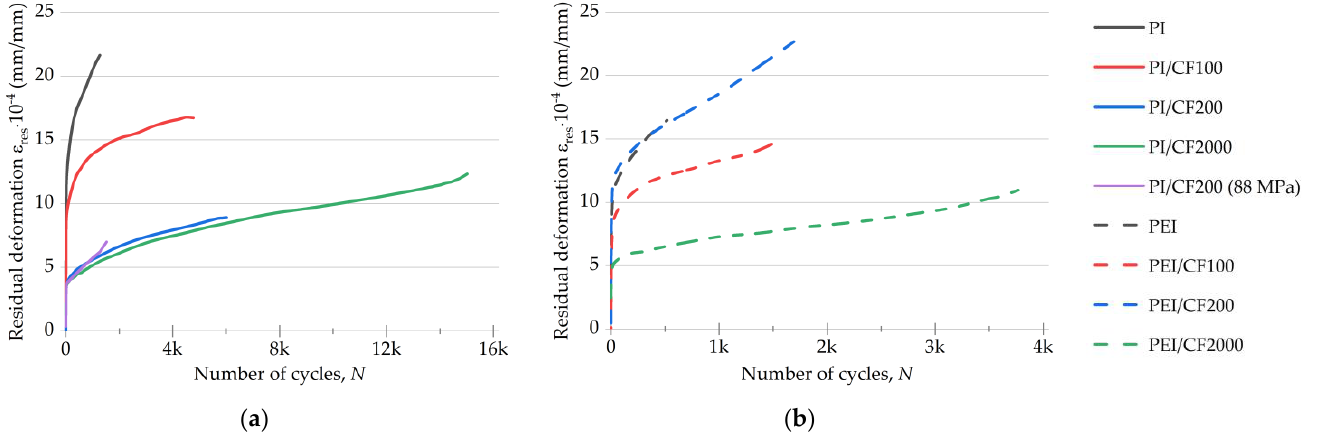
Figure 10. The changes in the residual strain values for the PI- ( a ) and PEI-based ( b ) composites under cyclic loads.